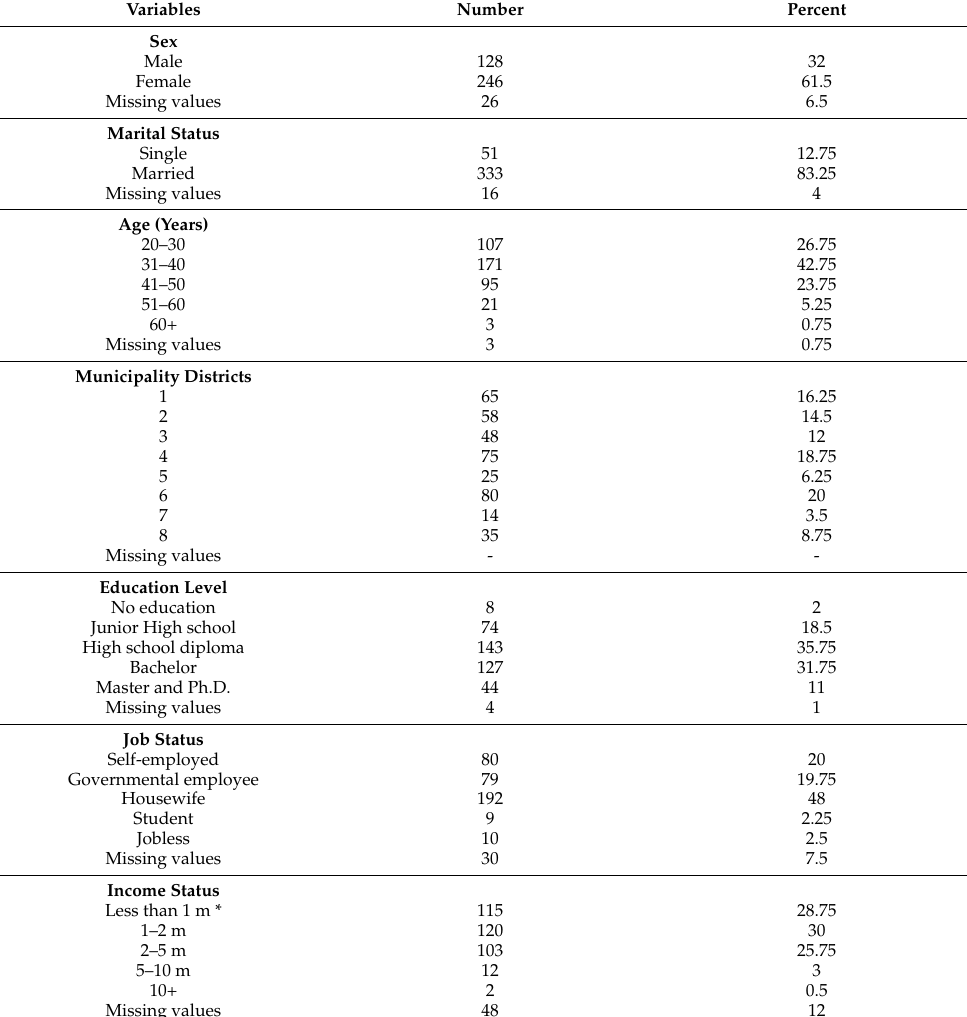
Table 1. Socio-demographic